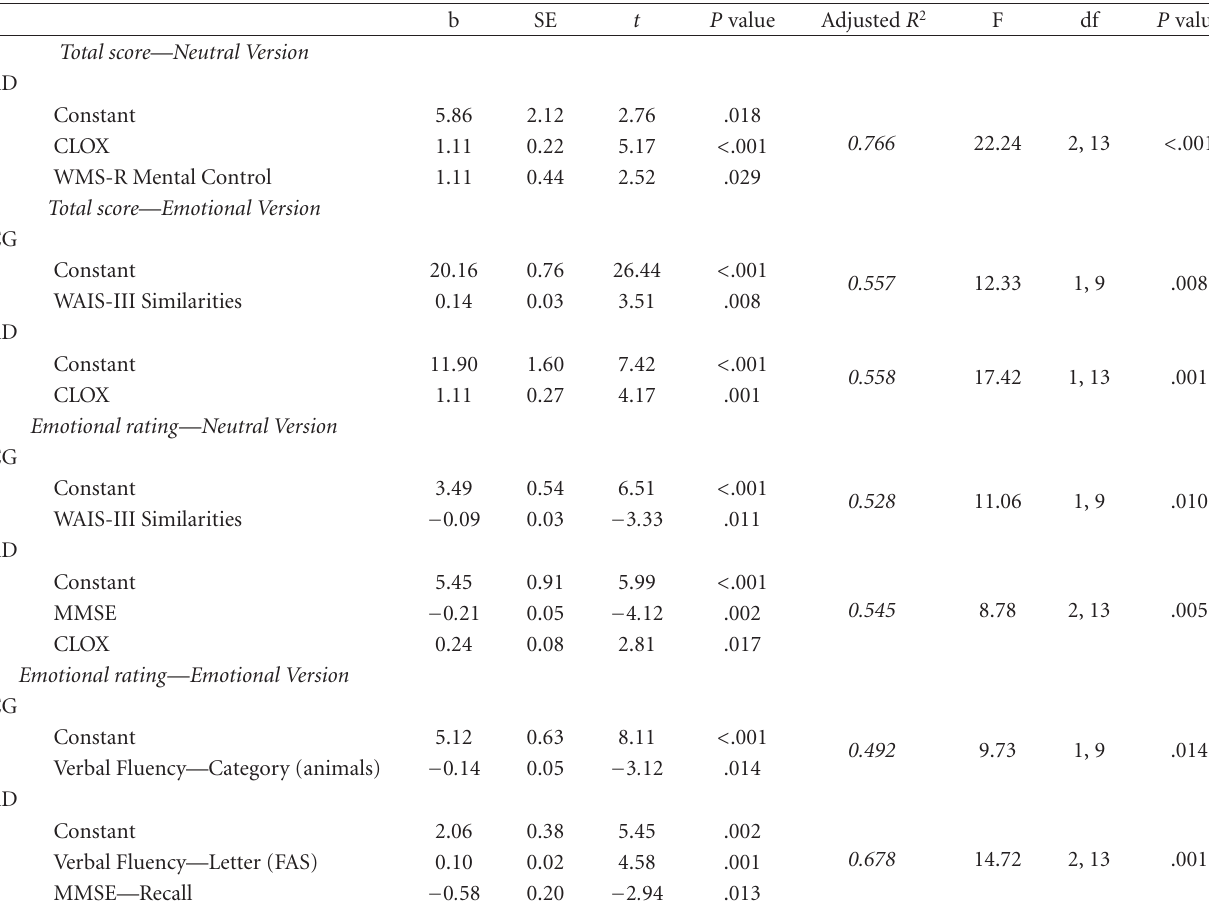
Table 2: Stepwise regression analyses results. SE, beta coe ffi cient Standard Error; df, degrees of freedom; CG, control group; AD, Alzheimer’s disease patients; CLOX, Clock Design Test; WMS-R, Wechsler Memory Scale-Revised; WAIS-III, Wechsler Adult Intelligence Scale-III; MMSE, Mini-Mental State